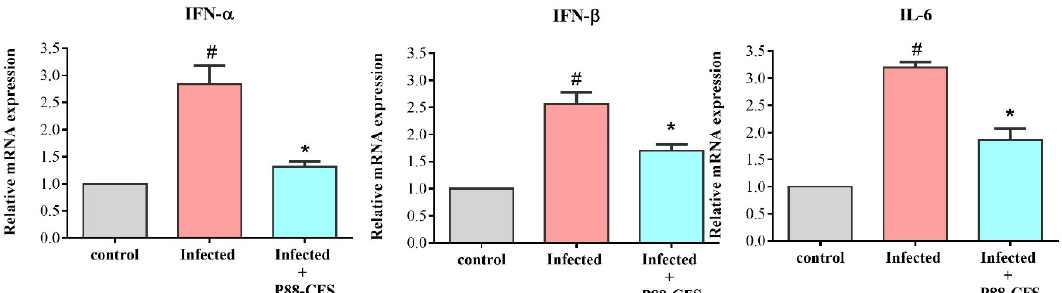
Figure 5. Gene expression of inflammatory markers in HEK 293 cells post infection with and without treatment of P88-CFS. The expression of IFN- α , IFN- β , and IL-6 were measured by qPCR and normalized to GAPDH. All the experiments were done in triplicate and statistical analysis was performed by t -test. Data are represented as the means ± SD of 3 independent experiments. * p < 0.05 compared with virus-infected cells; # p < 0.05 compared with control.